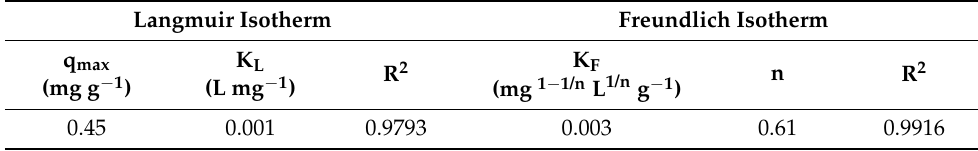
Table 3. Langmuir and Freundlich isotherm parameters and correlation coefficients of NH 3 adsorp- tion onto thermally treated volcanic tuff obtained by nonlinear